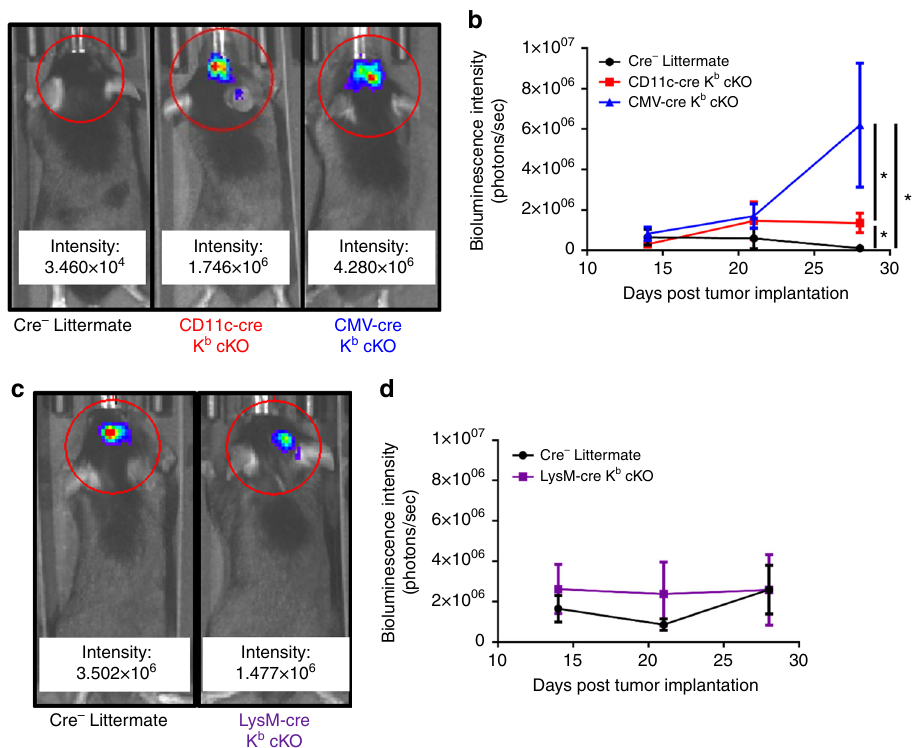
Fig. 8 CD11c-cre K b cKO mice have intermediate ability to control GL261 glioma growth. Tumor burden in GL261-quad cassette-bearing animals was assessed weekly via bioluminescence imaging beginning at day 14 post tumor inoculation. a Representative images at day 28 and b quanti fi cation demonstrate a loss of tumor control in CMV-cre K b cKO animals, and a less severe loss of tumor control in CD11c-cre K b cKO animals ( N = 5, 6, 6 per group, respectively). c Representative images at day 28 and d quanti fi cation demonstrate that tumor growth in LysM-cre K b cKO animals and cre-negative littermates was comparable ( N = 10 per group). Data presented as mean with error bars representing standard error of the mean (SEM). * denotes p < 0.05 by Mann − Whitney U Test or one-way ANOVA with Holm − Sidak